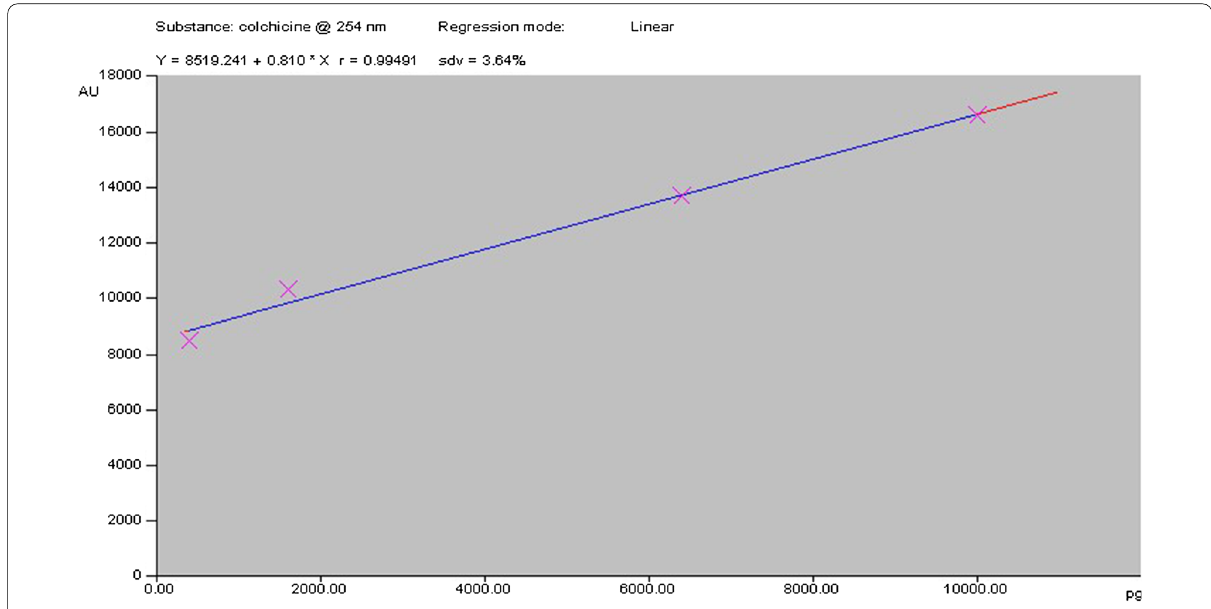
Fig. 3 Calibration curve of Colchicine at 254